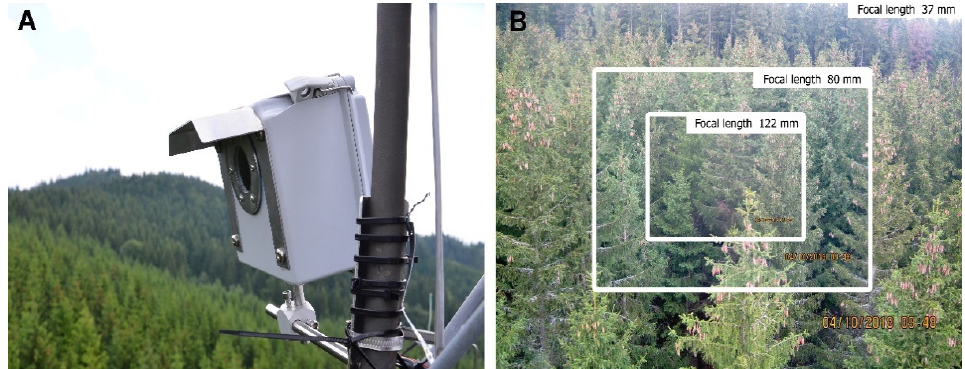
Figure 2. The PhenoCam EMS 800 (EMS Brno, the Czech Republic) placed on the top of the meteorological tower ( A ) and the example of photos ( B ) at the ESP Rajec, which were used for evaluation of P growth ; tree rectangles represent views of different focal length (frames).